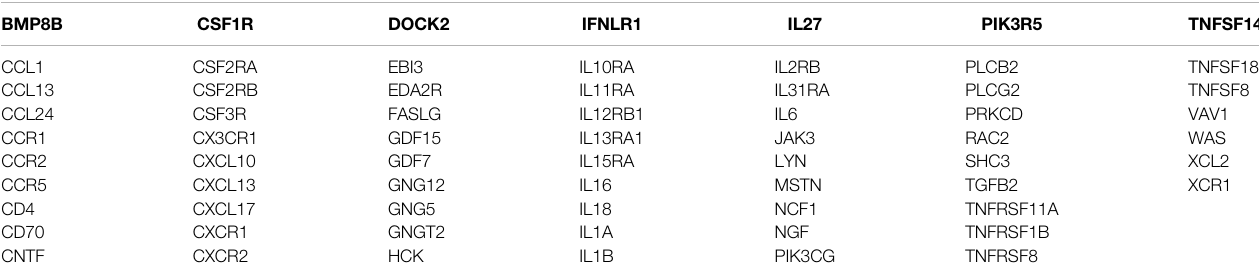
TABLE 2 | Genes in the cytokine – cytokine receptor interaction and chemokine signaling pathways.